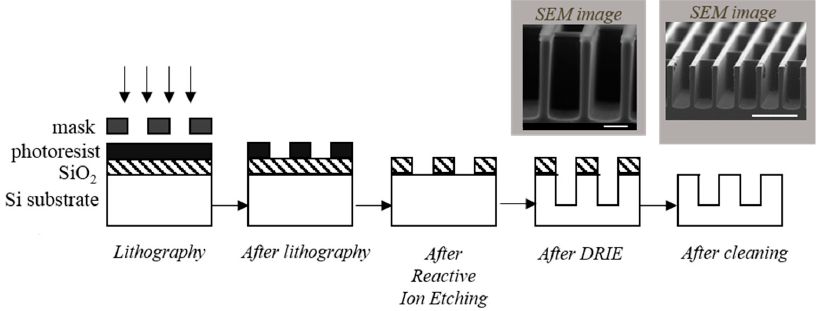
Figure 1. Schematic representation of 3D substrate material preparation. All scale bars in scanning electron microscopy (SEM) images represent 10 µm.